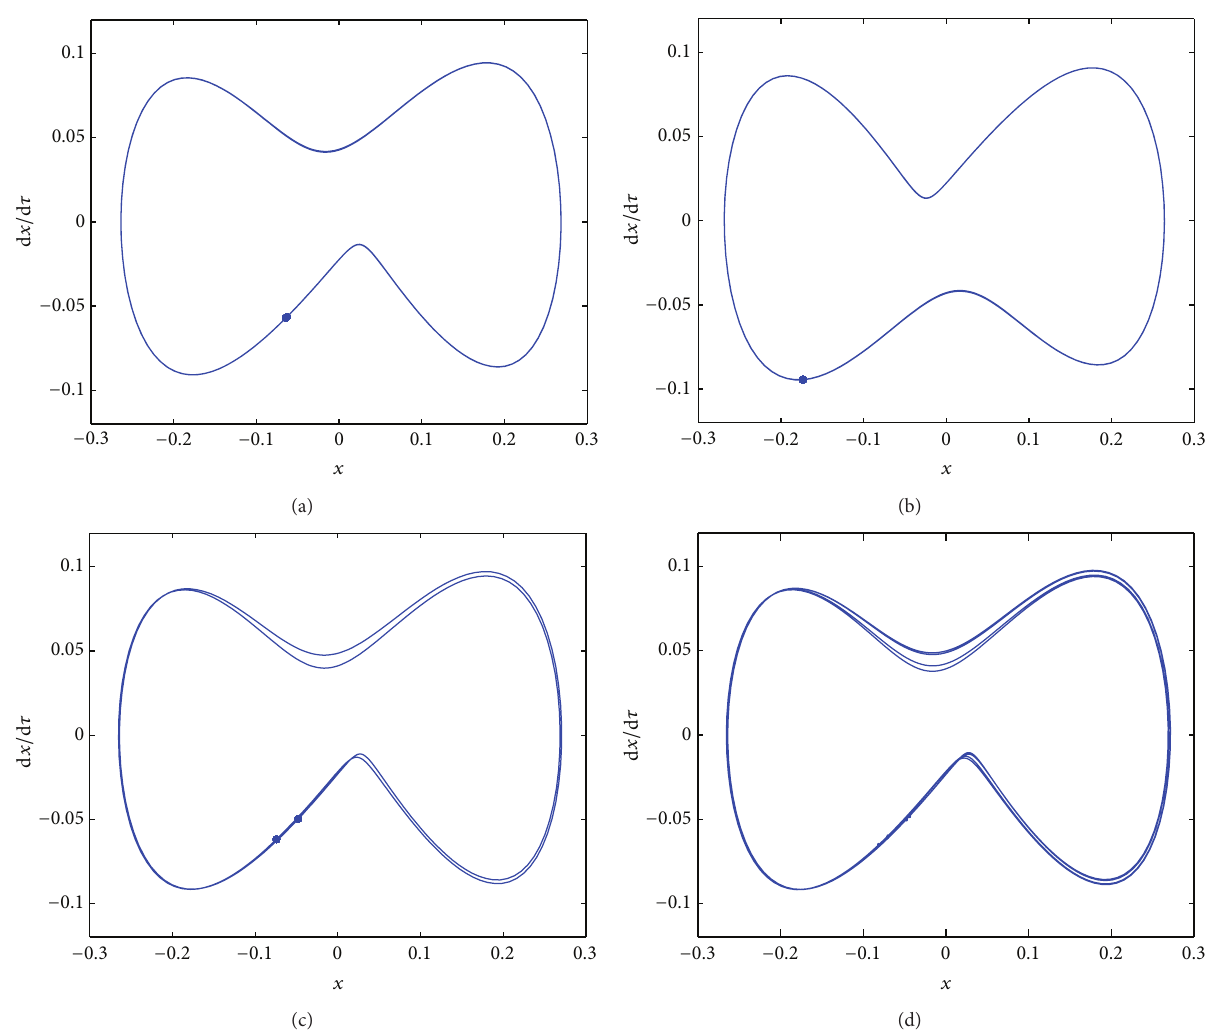
Figure 7: Phase trajectory and Poincar´e maps for 𝜔 𝑒 = 12 Hz with increasing 𝑍 𝑒 , where (a) asymmetric period-1 solution, 𝑍 𝑒 = 2𝑔 ; (b) dual solution, 𝑍 𝑒 = 2𝑔 , with different initial conditions (−0.5,0, 0) ; (c) period-2 solution, 𝑍 𝑒 = 2.06𝑔 ; and (d) period-4 solution, 𝑍 𝑒 = 2.07𝑔 .